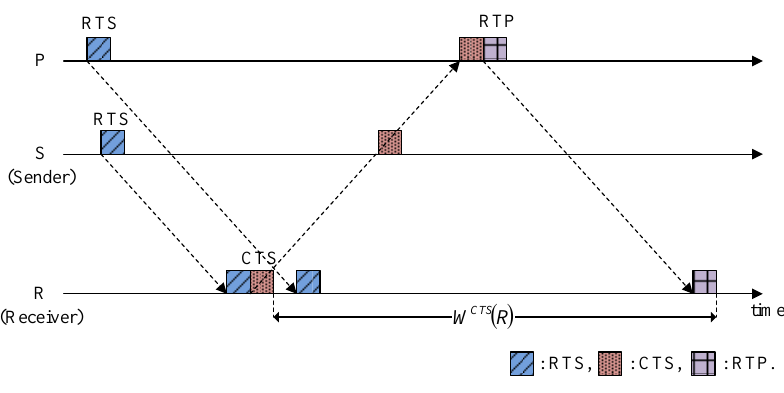
Figure 6. Solution to the spatial unfairness